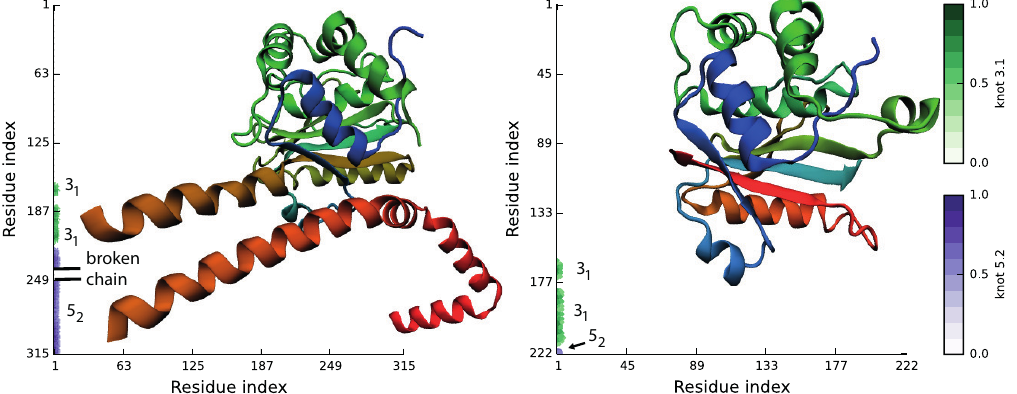
Figure 3. Molecular structures and matrix representation for ubiquitin C-terminal hydrolases from human (PDB ID 4uf5, left) and Plasmodium falciparum (PDB ID 2wdt, right). The matrix shows that even though the sequence similarity between proteins is very low, they possess the same knotting motif, K5 2 3 1 3 1